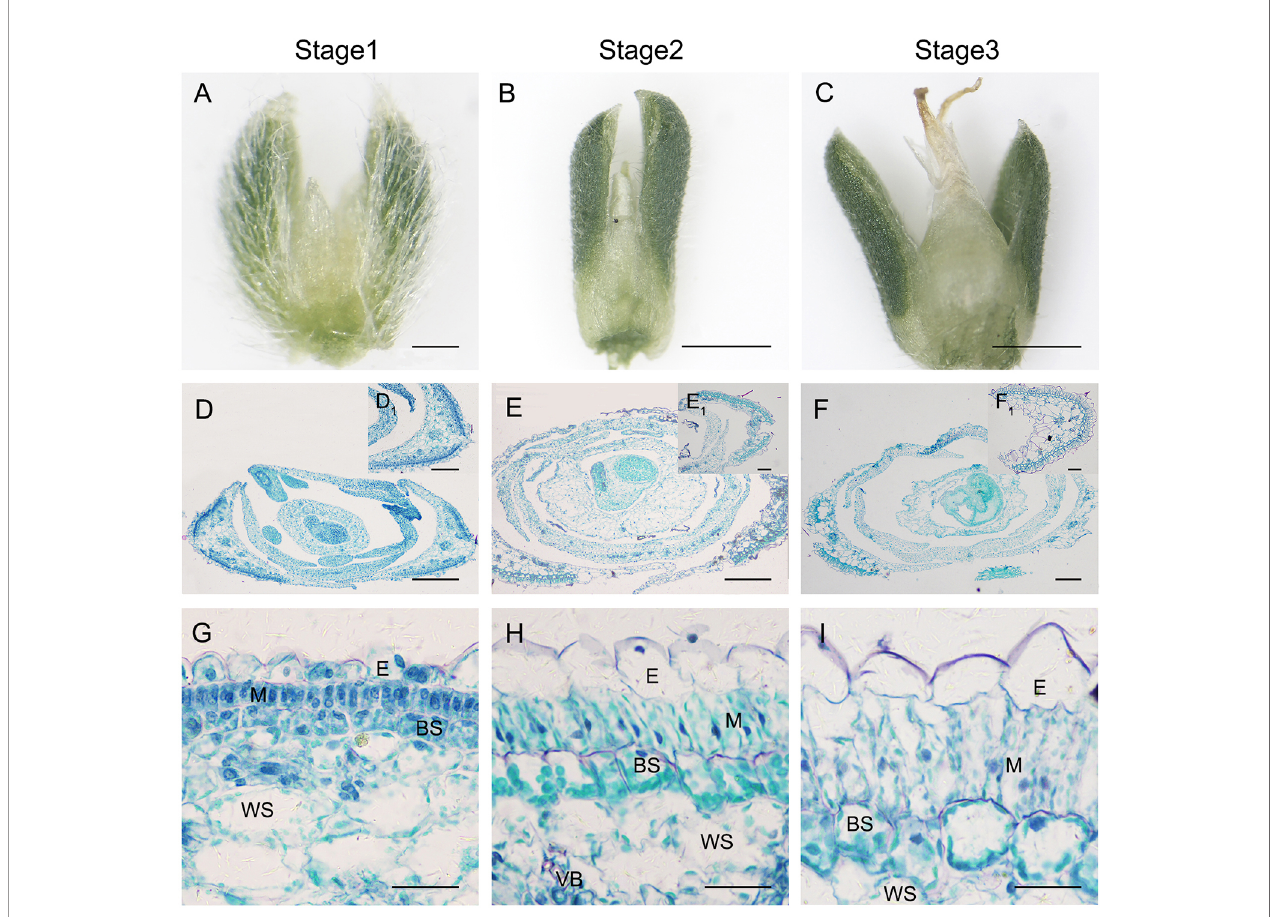
FIGURE 9 | Anatomic structure of sepal in S. ferganica with transverse sections in the middle part of the fl ower. (A – C) Developing fl owers, showing sepals on both sides; (D – F) Transverse sections of developing fl owers; (D 1 – F 1 ) Sepal section insets in the upper right position of D – F; (G – I) Detailed views of anatomic structure of sepal. Stage 1, Stage 2, Stage 3: different developmental times of fl ower. BS, bundle sheath; E, epidermis; H, hypodermis; M, mesophyll; VB, vascular bundle; WS, water storage. The images were acquired from the middle part of the fl owers of indoor plant. Scale bar in A, (D 1 – F 1 ) is 100 µm; in B, C is 500 µm; in D – F is 200 µm; in G-I is 50